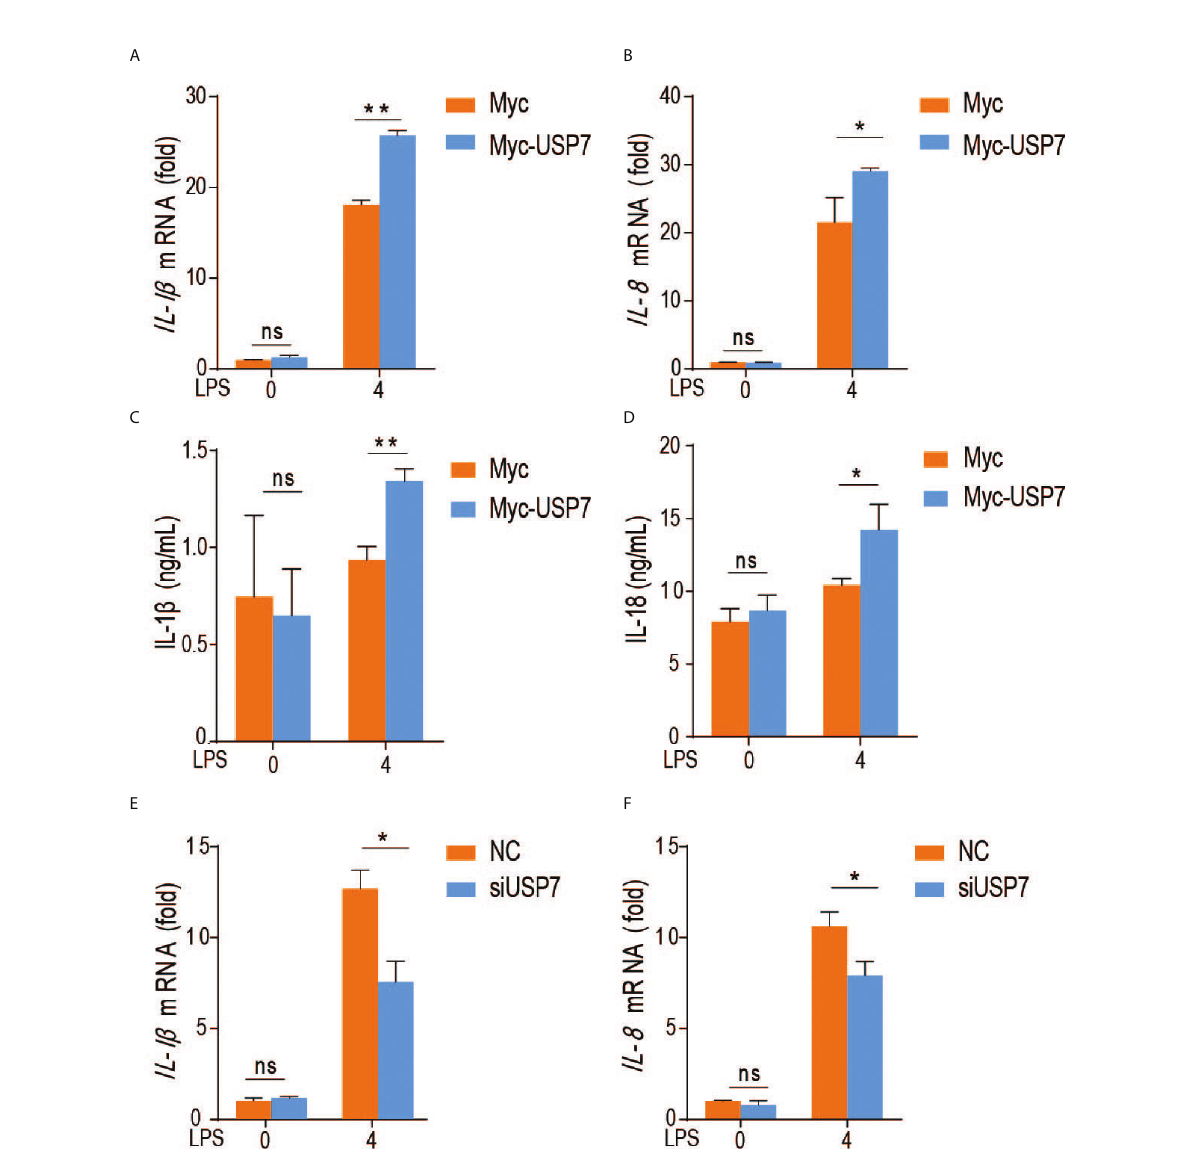
FIGURE 3 ChUSP7 affects the expression of immune factors in HD11. Abundance of IL-1 b and IL-8 mRNA (A, B) and protein levels (C, D) in chicken HD11 macrophages and cell supernatants with overexpressed (E, F) chUSP7 after stimulation with LPS for 4 h. IL-1 b and IL-8 mRNA abundances in chicken macrophages transfected with siRNA for chUSP7 after stimulation with LPS for 4 h. * p < 0.05, ** p < 0.01; error bars re fl ect ± SD. ns, Not Statistically Signi fi